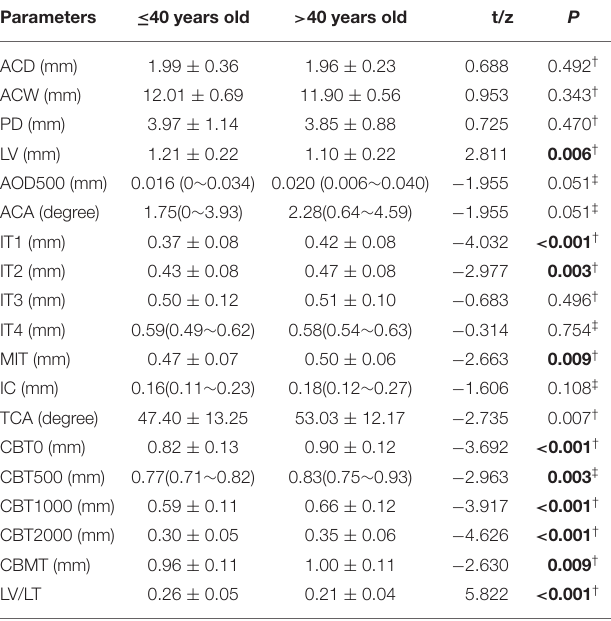
TABLE 2 | Parameters of anterior segment of different age groups. Parameters